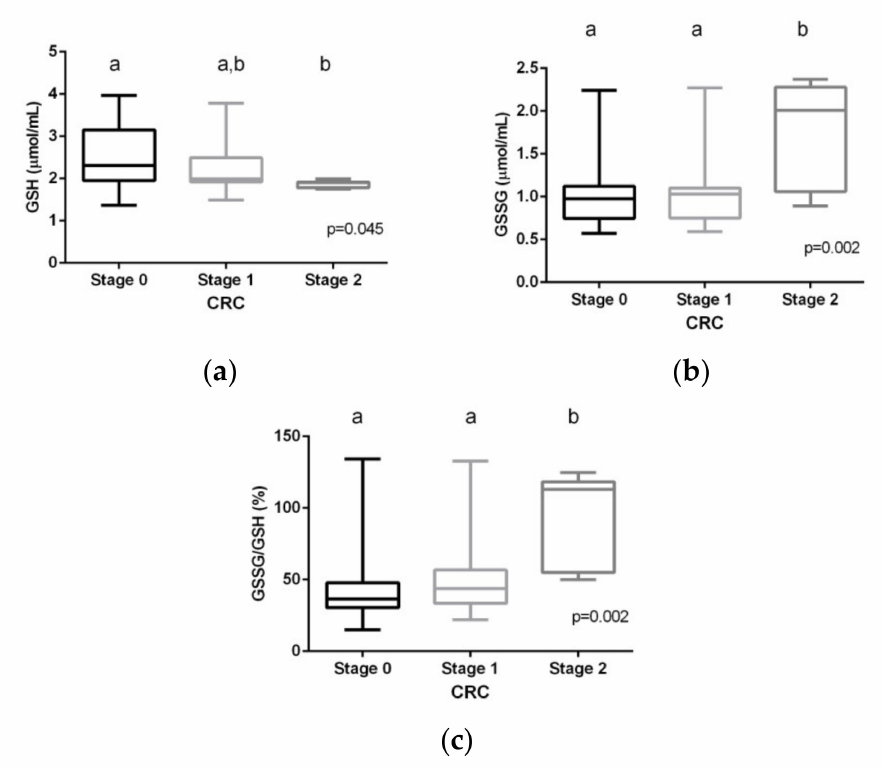
Figure 3. Reduced ( a ) and oxidized ( b ) glutathione levels and GSSG/GSH% ratio ( c ) grouped by tumor stages. Data are expressed as box and whiskers (stage 0, n = 44; stage 1, n = 26: stage 2, n = 9). Values with different superscript letters (a, b) were significantly different when the 3 groups were compared by one-way ANOVA followed by a Student–Newman-Keuls post hoc test. GSH: reduced glutathione; GSSG: oxidized